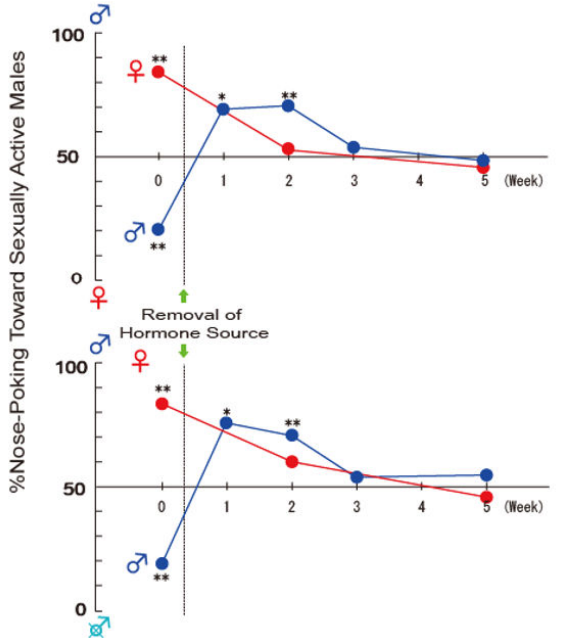
Figure 2. Effects of sex hormone ablation on sexual preference. The results in preference tests between sexually active male vs. estrous female and between sexually active male vs. castrated male are shown in the upper and lower panels, respectively. Ovariectomized female rats were primed with estrogen and progesterone in the preference test at week 0, and thereafter tested without sex hormone treatment. Male rats were gonadally intact and castrated immediately after the preference test at week 0. Male rats transiently displayed the feminine type of sexual preference during 2 weeks after castration